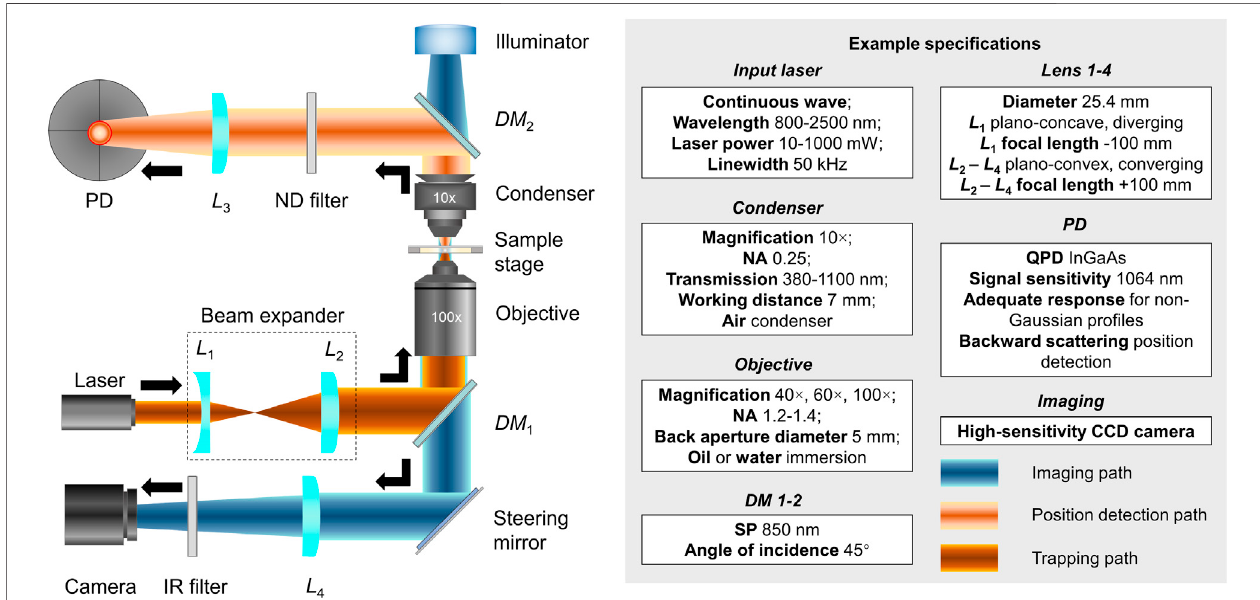
FIGURE 1 | Generic con fi guration of an optical tweezer system. Left : Optical con fi gurations of the trapping ( dark orange ), imaging ( light orange ), and position detectionlightpathsandassociatedoptics( blue ). Right :Examplespeci fi cationsfortheinputlaser,condenser,objective,DMs,lenses,PD,andimagingparts.Mentioned abbreviations: L 1-4 , lens; PD, position detector; ND, neutral density; DM 1-2 , dichroic mirrors; IR, infrared; NA, numerical aperture; SP, short pass; QPD, quadrant photodetector; CCD, charge-coupled device.